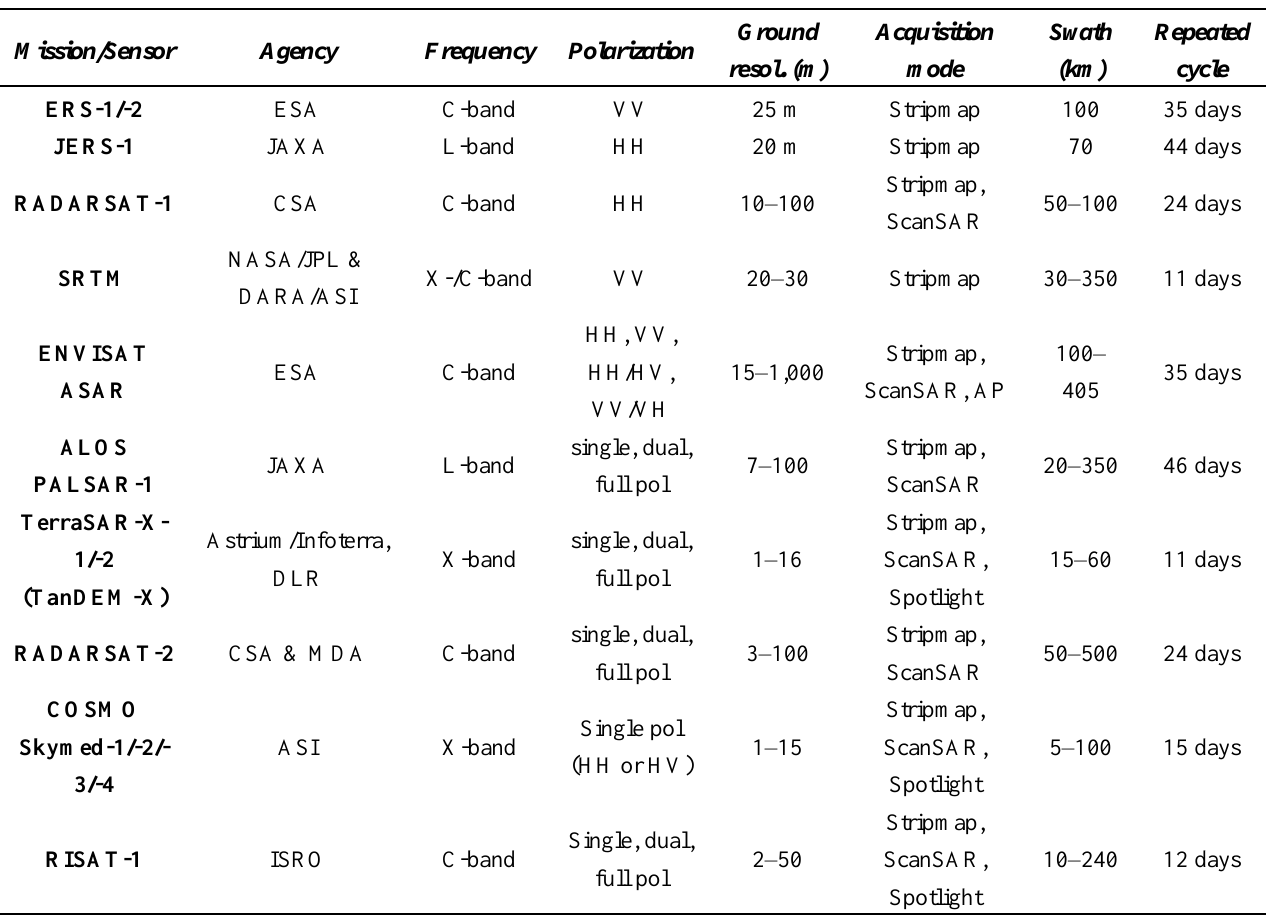
Table 1. SAR missions and sensors (VV = Vertical transmit and Vertical receive polarizations; HH = Horizontal transmit and Horizontal receive; HV = Horizontal transmit and Vertical receive).